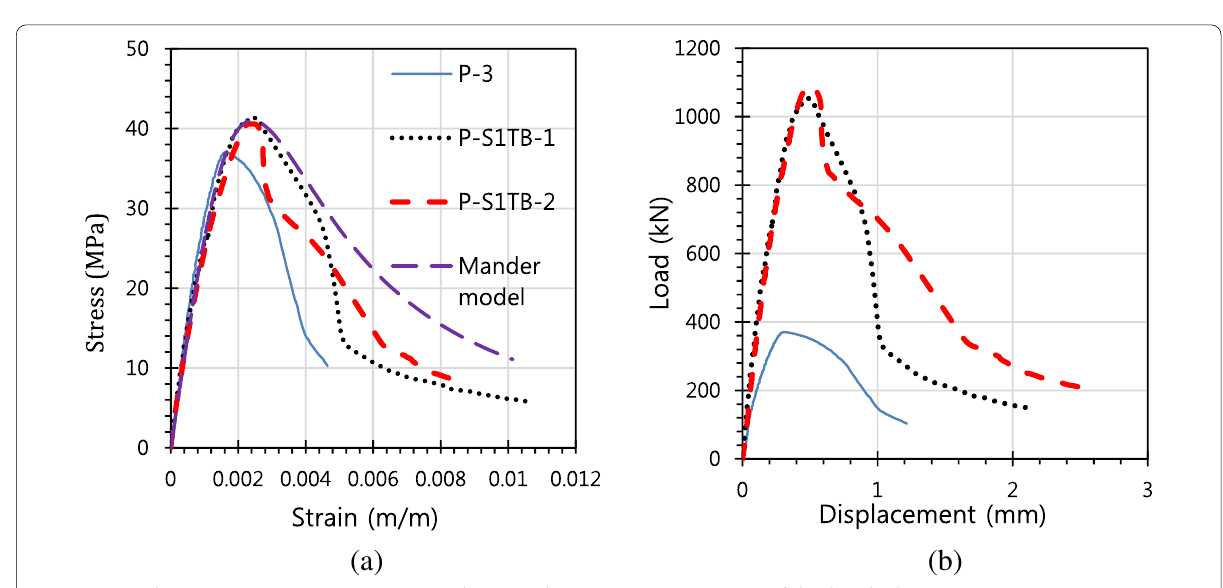
Fig. 15 Control specimen vs. prismatic specimens with FRCM tube (Type-3): a stress vs. strain, b load vs.